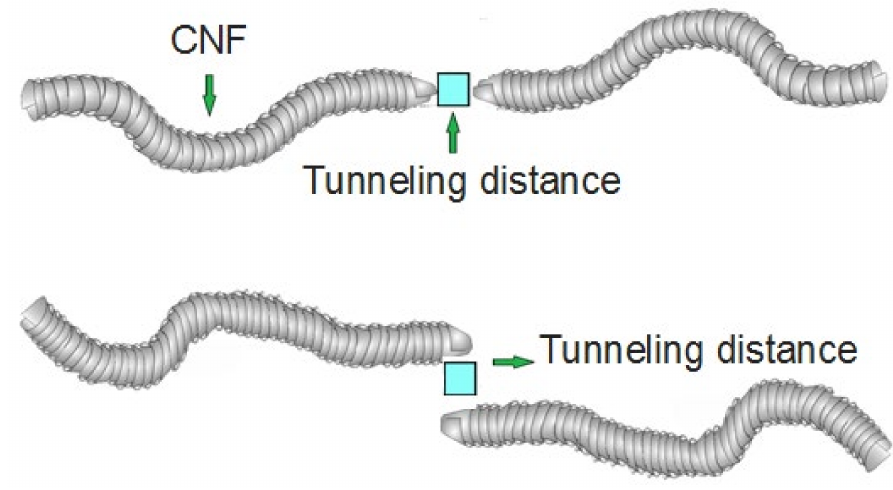
Figure 2. Placement of tunneling distance between adjacent